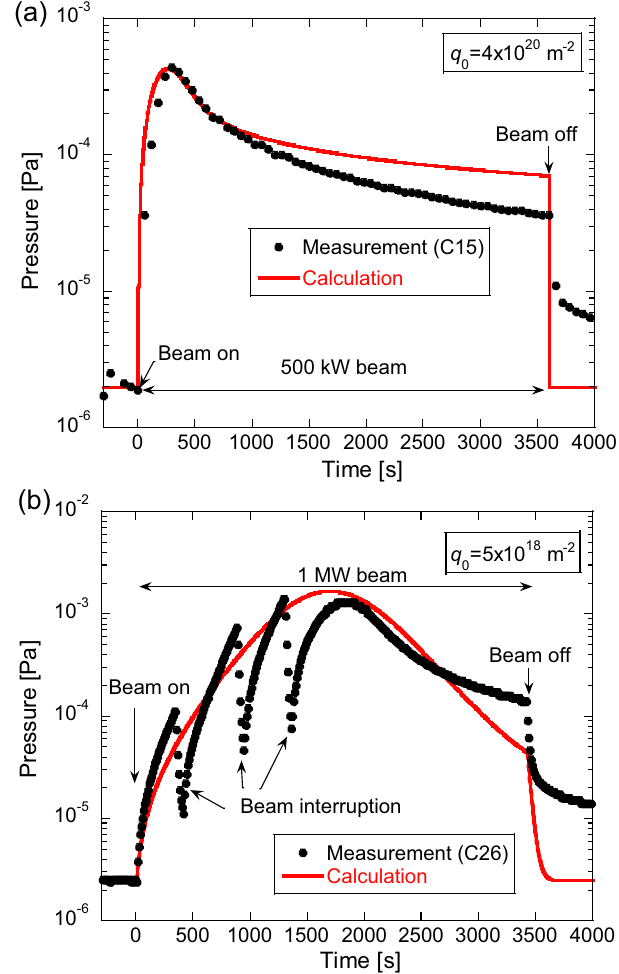
FIG. 19. Comparison of the calculated pressure with the one measured bythe CCGs. The origin of the horizontal axis is the time when the beam operation started. The adjusted q 0 value is also presented in each panel. (a) Pressure in C15 at point G of Fig. 14 during the beam operation with 500 kW power [Fig. 17(b)]. (b) Pressure in C26 at point X of Fig. 14 during the beam operation with 1 MW power [Fig. 18(a)]. The beam interruptions during the beam operation are not considered in the